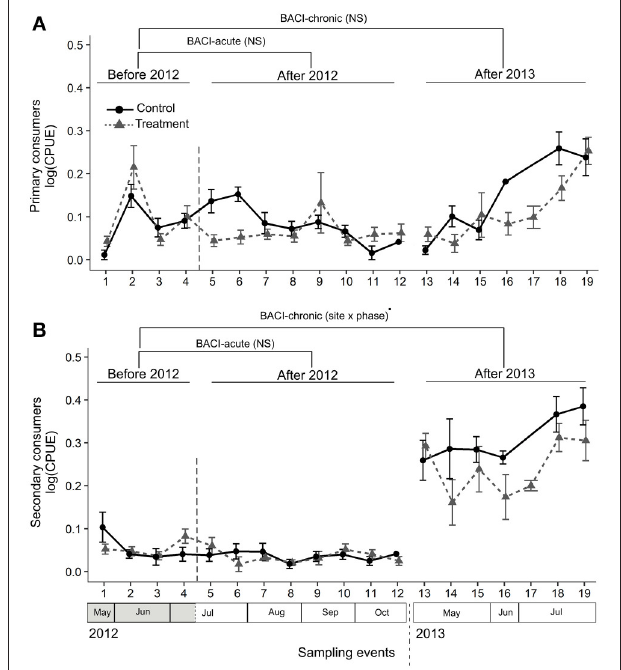
FIGURE 4 | Abundance (CPUE) of ground-dwelling primary (A) and secondary (B) consumers was compared across sampling events within and among years using a BACI design. Control and Treatment sites were first compared prior to and during experimental illumination in 2012 (BACI-acute; Before 2012 and After 2012). Sites were then compared prior to illumination in 2012 with the same period of the year in 2013, after experimental illumination (BACI-chronic; Before 2012, After 2013). Significant site × phase interactions (GLS) are shown as · 0.05 < p < 0.07; NS p > 0.07. Means across all traps with standard errors are shown for the two sites at each sampling